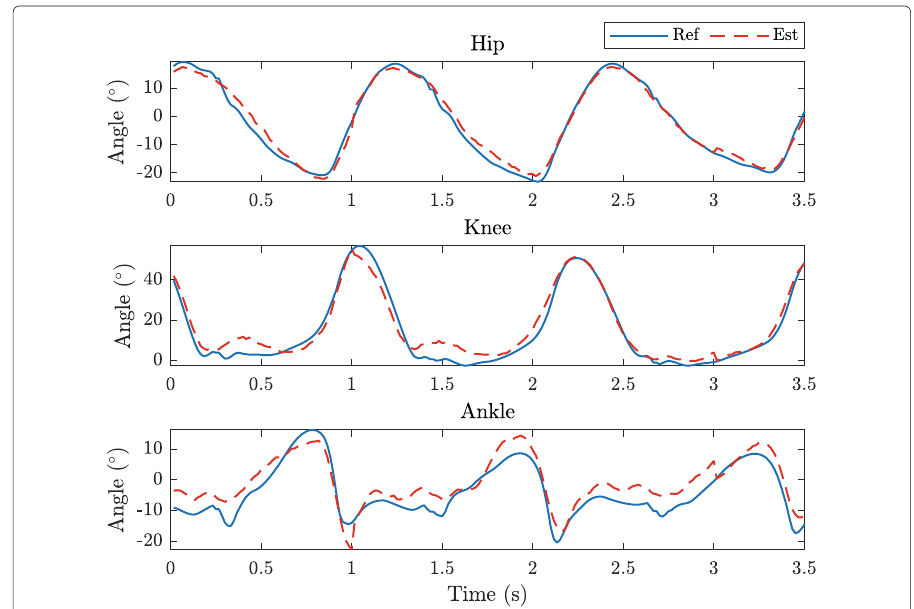
Fig. 10 Estimated lower limb joint angles in the sagittal plane using the NARX with input set 4 and the reference lower limb joint angles from the wearable system. Blue solid lines and red dashed lines are the reference and the estimated joint angles, respectively